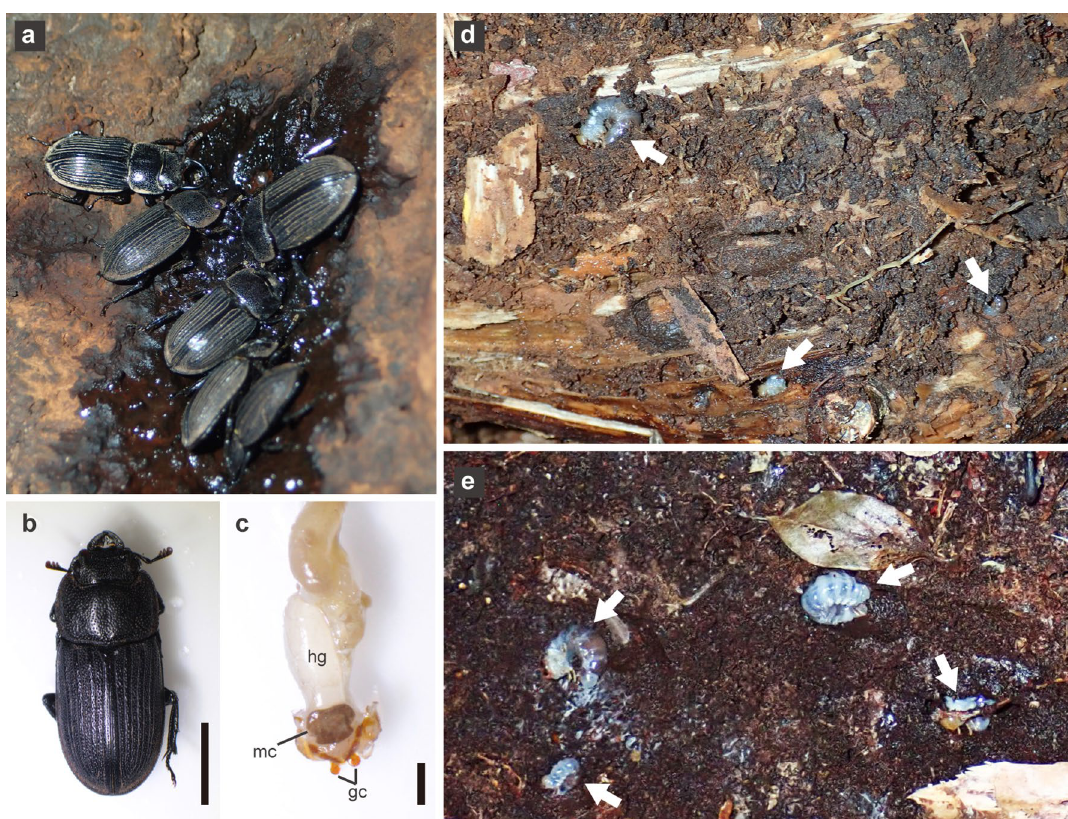
Figure 1. Adults and larvae of Aegus subnitidus. ( a ) Adults of A. subnitidus visiting fermented sap of Quercus glauca. ( b ) An adult female. ( c ) Internal organs dissected from an adult female. ( d , e ) Larvae of A. subnitidus (arrows) in the surface area on the underside of highly decomposed wood of Pinus densiflora on the ground ( d ) and in the humus in contact with highly decomposed wood of P. densiflora ( e ). gc gonocoxite, hg hind gut, mc mycetangium. Scale bars = 5.0 mm in ( b ) and 1.0 mm in ( c